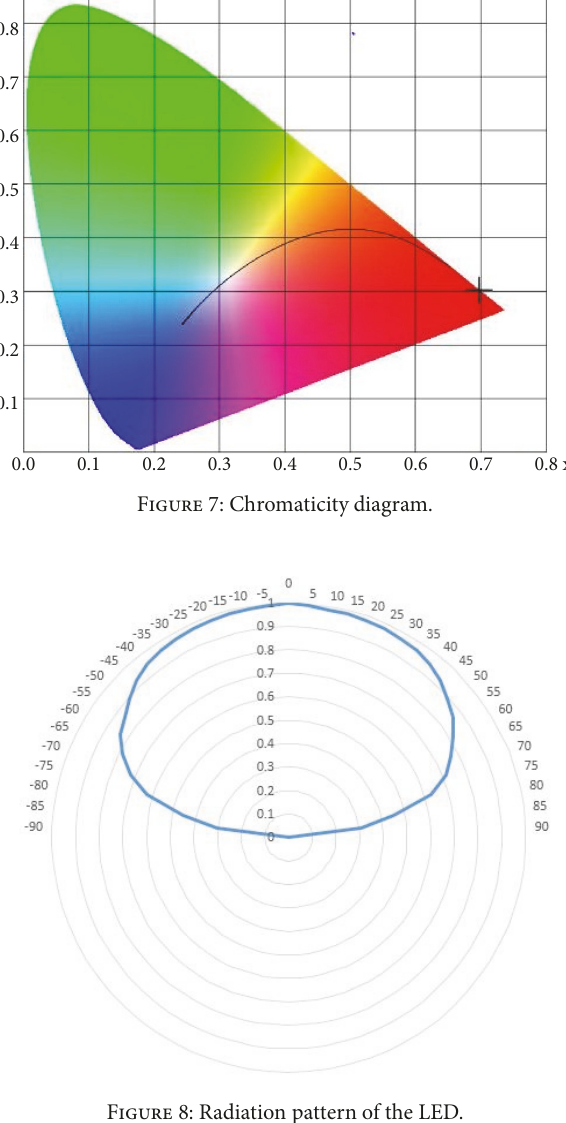
Figure 8: Radiation pattern of the LED.